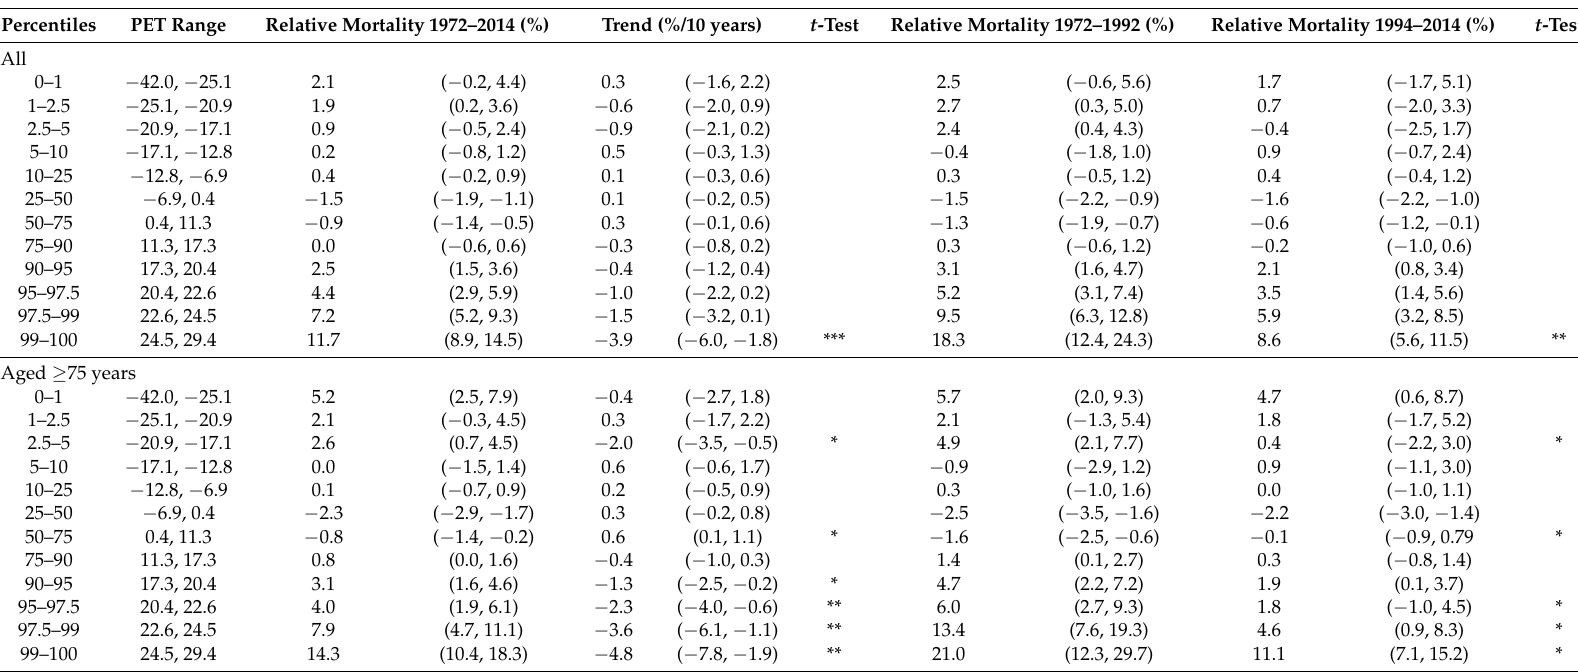
Table 1. Mean relative mortality (95% CI) of different age groups in percentiles of daily mean values of physiologically equivalent temperature (PET)at the Helsinki-Vantaa airport, and their linear time trends in the period of 1972–2014 with statistical significance. Mean relative mortality in two 21-year sub-periods, 1972–1992 and 1994–2014, and the statistical significance of the differences in relative mortality between the